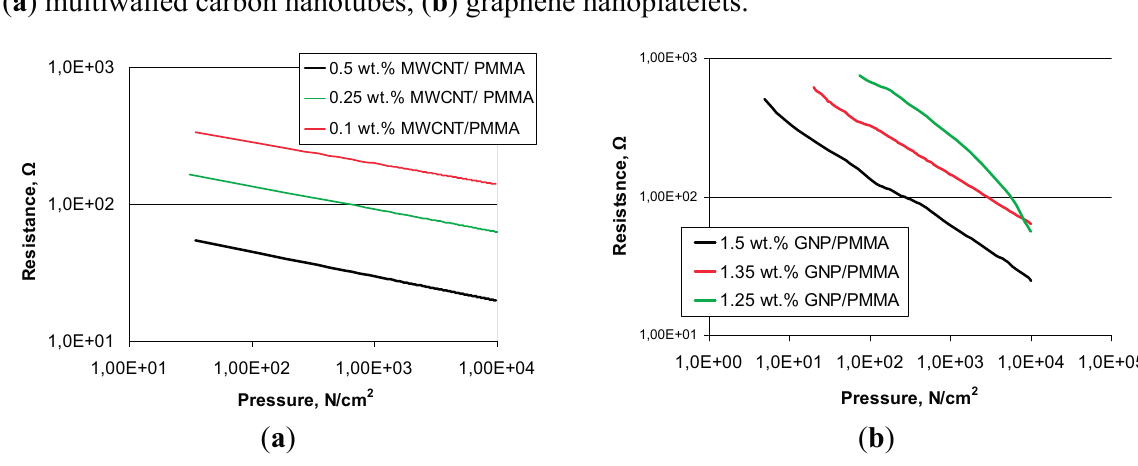
Figure 3. Characteristics of the pressure sensors based on the PMMA resin pastes with: ( a ) multiwalled carbon nanotubes, ( b ) graphene